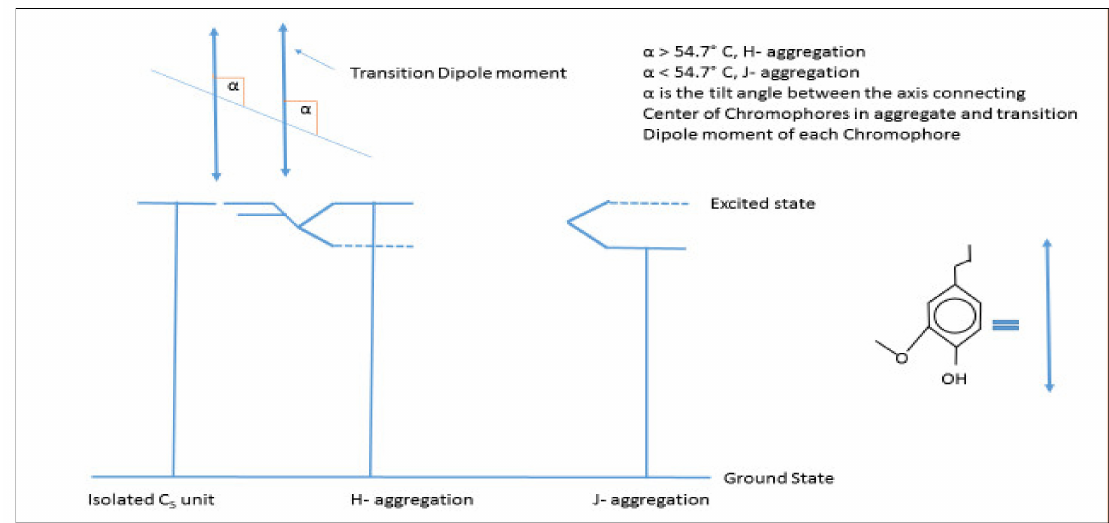
Figure 3. Representation of energy levels of H and J type aggregations